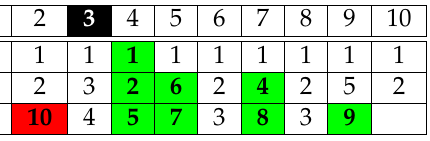
Figure 8. An example of an optimal scheduling for N = C = 10 and B ∗ = 3. The request arrival slot is illustrated in black. The green video segments are successfully downloaded. The red video segment is